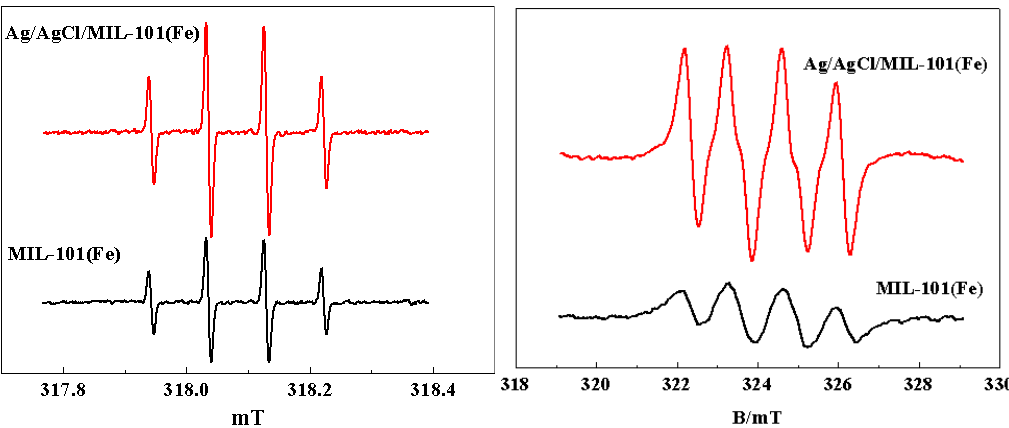
Figure 15. The ESR spectra of DMPO ‐ HO ∙ adducts ( a ) and DMPO ‐ O 2 ∙ ‐ adducts ( b ) in the photo ‐ Fenton system with MIL ‐ 101(Fe) and Ag/AgCl/MIL ‐ 101(Fe).